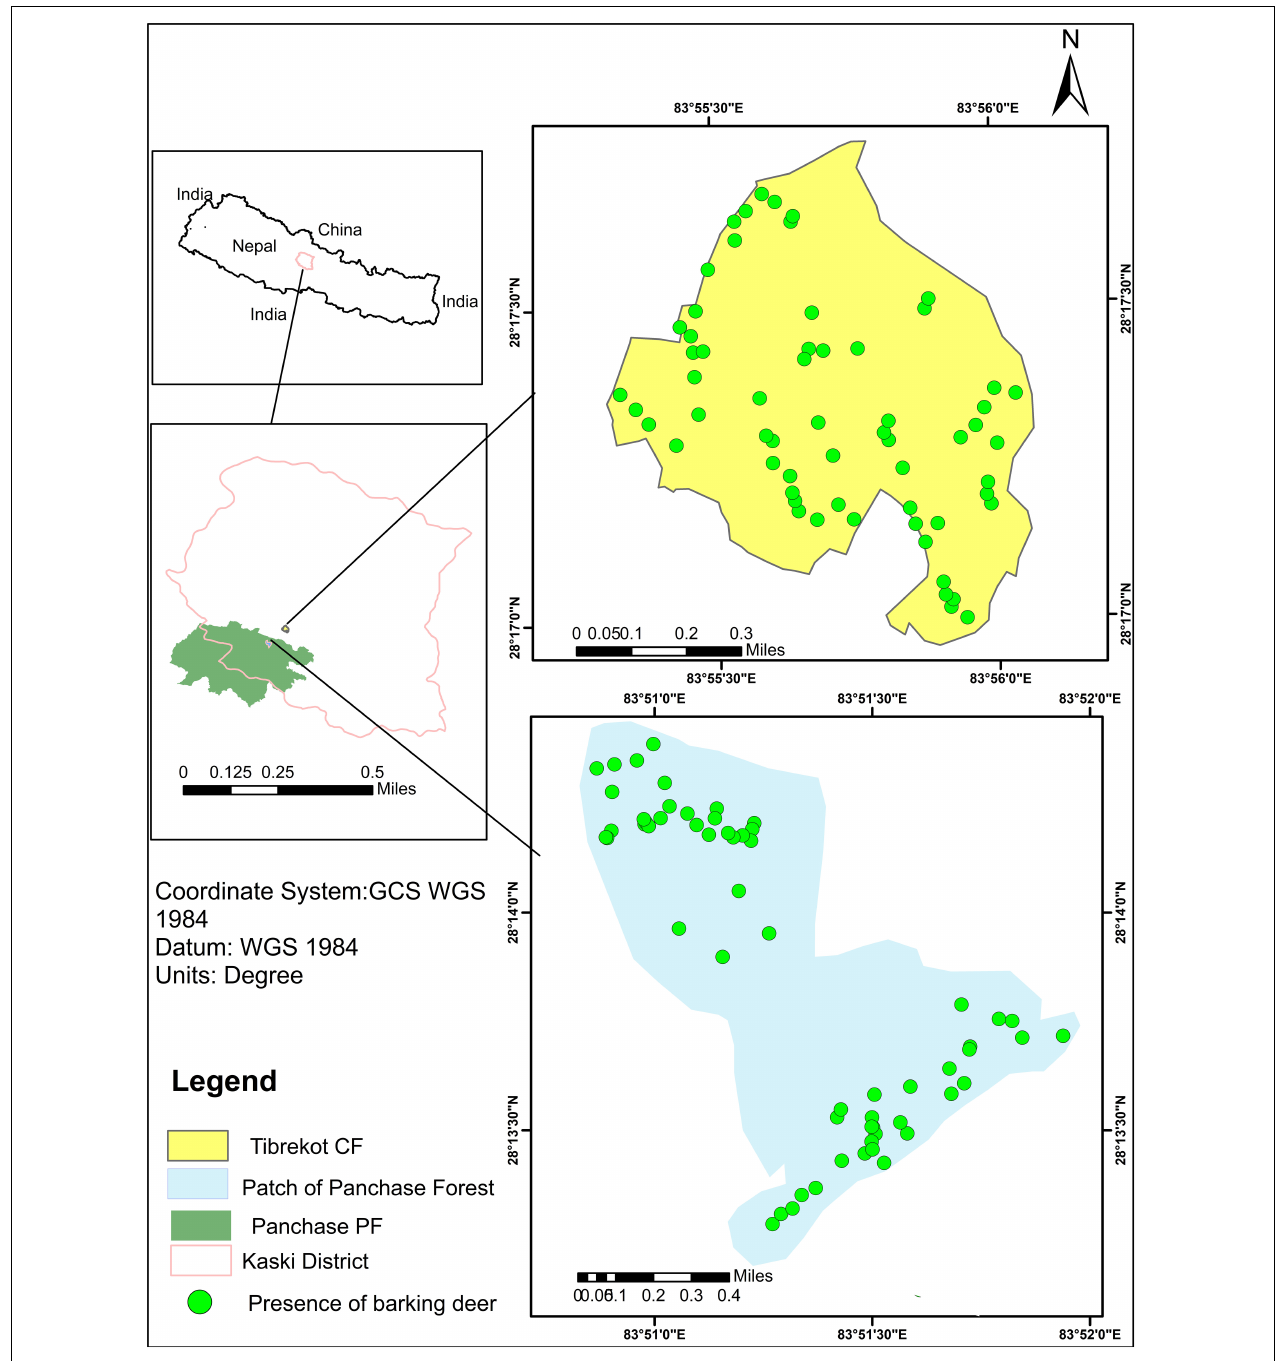
FIGURE 2 | Map showing the location of study areas in Kaski Nepal: Tibrekot Community Forest (CF) and patch of Panchase Protected Forest (PF).